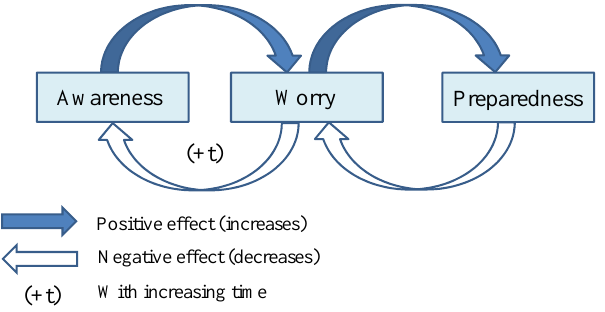
Fig. 1. Relationship between elements of risk perception (from Raaijmakers et al., 2008).